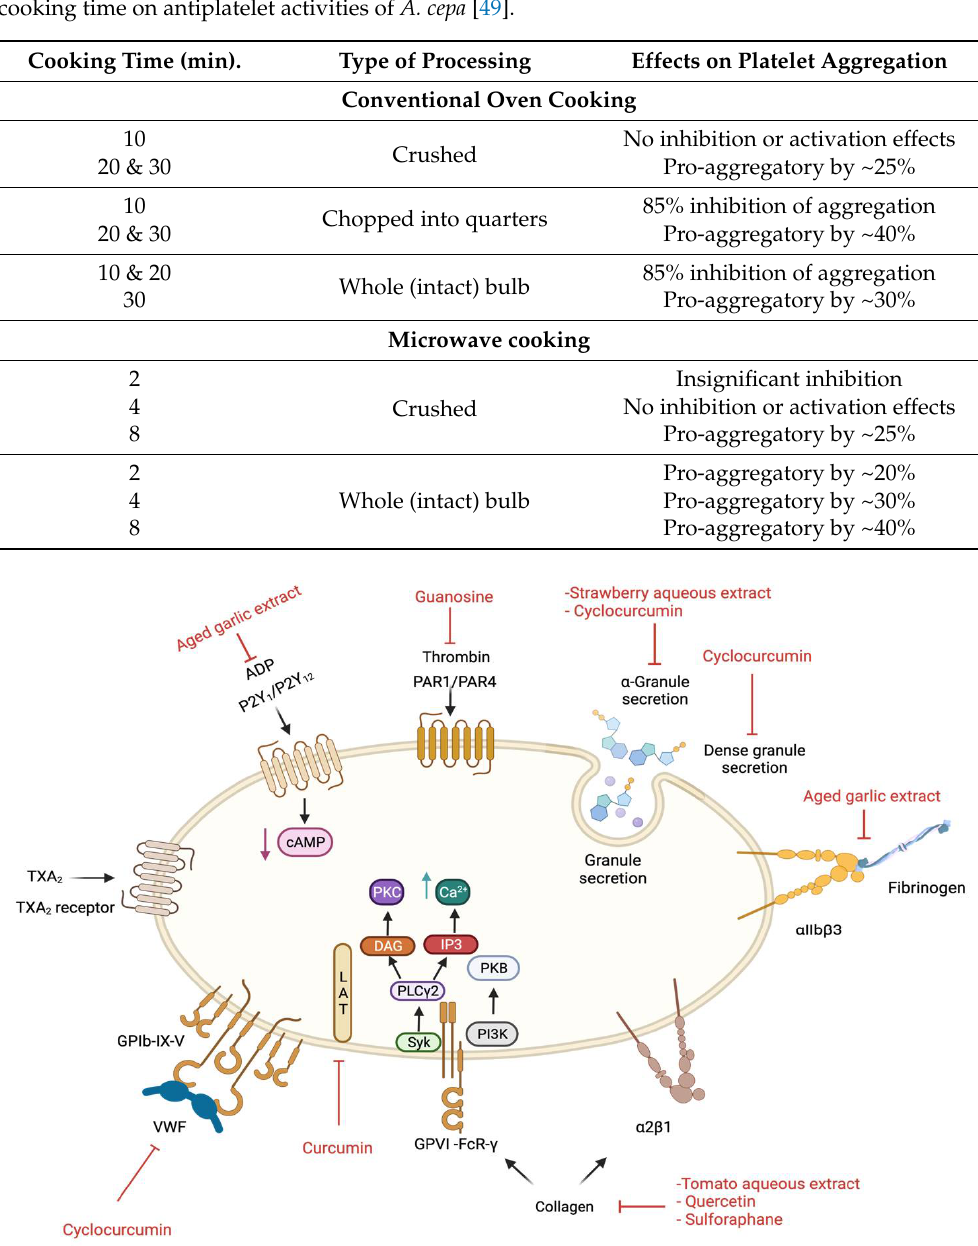
Figure 2. Signalling pathways that are affected by selective plant extracts and their compounds in platelets. cAMP; cyclic adenosine monophosphate, DAG; diacylglycerol, IP3; inositol trisphosphate, PI3K; phosphoinositide 3-kinase, PKB; Protein kinase B, PKC; Protein kinase C, PLC γ 2; phospholipase C γ 2, and Syk; spleen tyrosine kinase. This image was created in BioRender.com (accessed on 23 December 2021). using the information provided in this